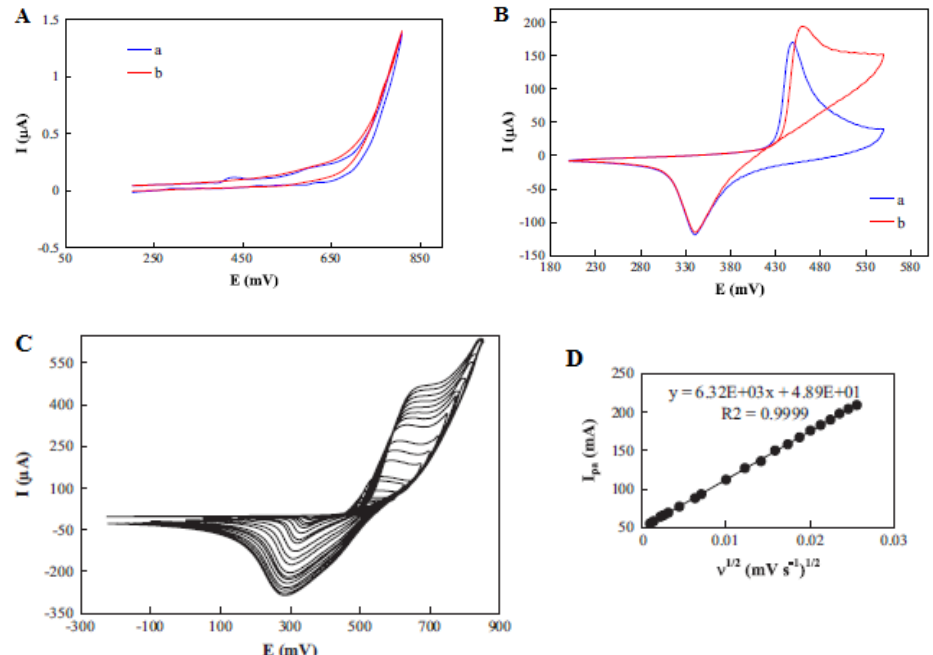
Figure 9. Cyclic voltammogram (CV) of ( A ) a CPE and ( B ) an MCPE without (curve ( a )) and with (curve ( b )) 10 m/mol choline, at scan rate of 50 mV s − 1 ; ( C ) CV of different scan rates in the range of 1–1000 mV s − 1 ; and ( D ) linear relationship of the anodic peak current and square root of the scan rate. Reprinted by permission from [44]. Copyright (2014) Elsevier.